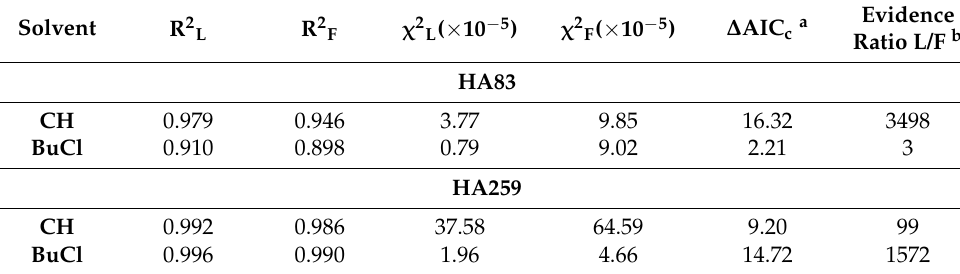
Table 1. Fit accuracy comparison for the Langmuir and Freundlich models.